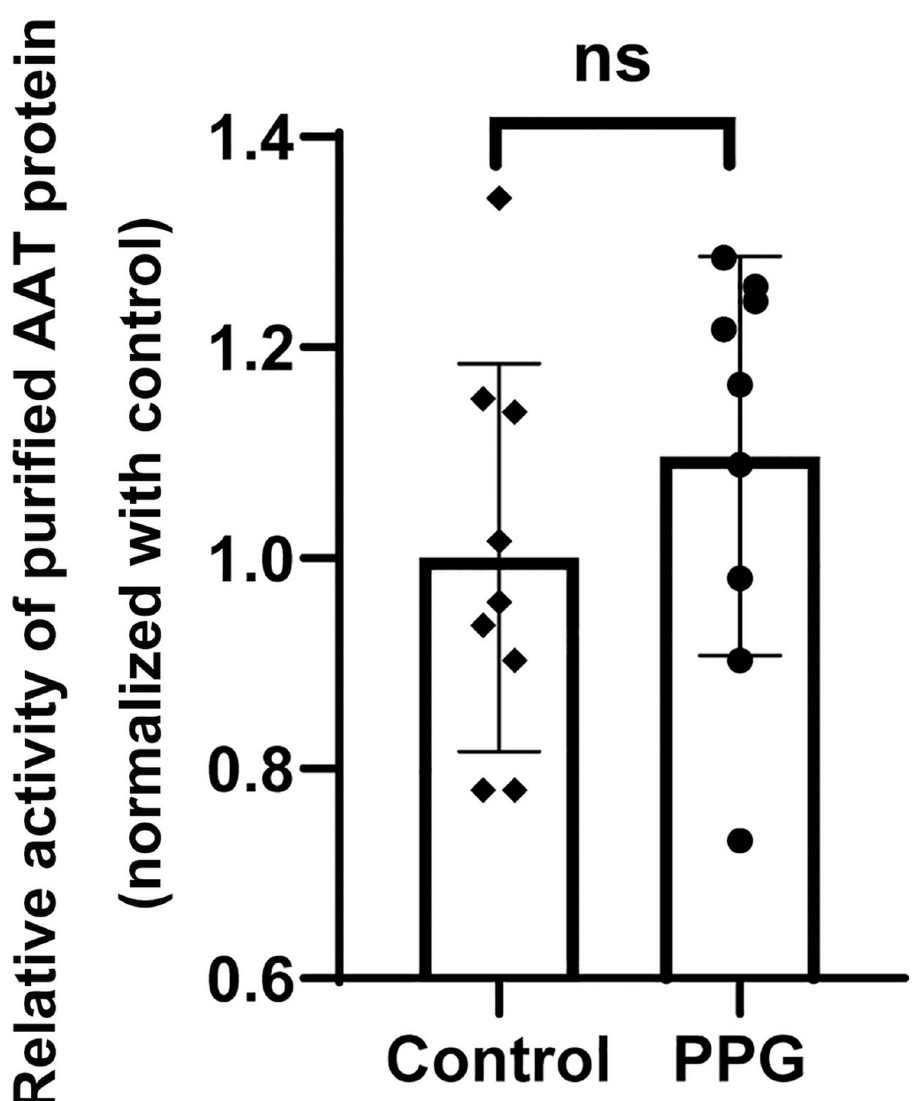
Fig 1. PPG had no direct effect on AAT activity. Purified AAT protein was incubated with or without PPG (100 μ mol/L) for 30 min at 37˚C. Data are presented as mean ± SEM; n = 9 in each group; Student’s t-test; ns, not